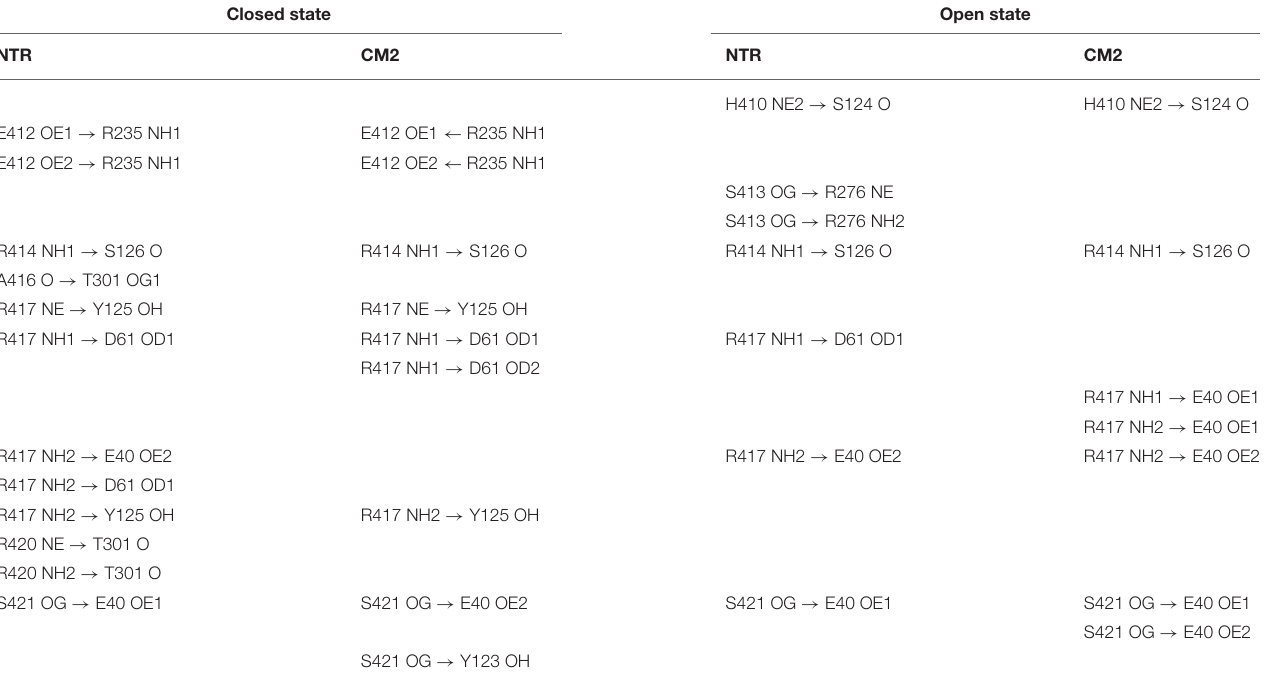
TABLE 5 | Hydrogen bonding between the central helix and domains A, B of NTR.